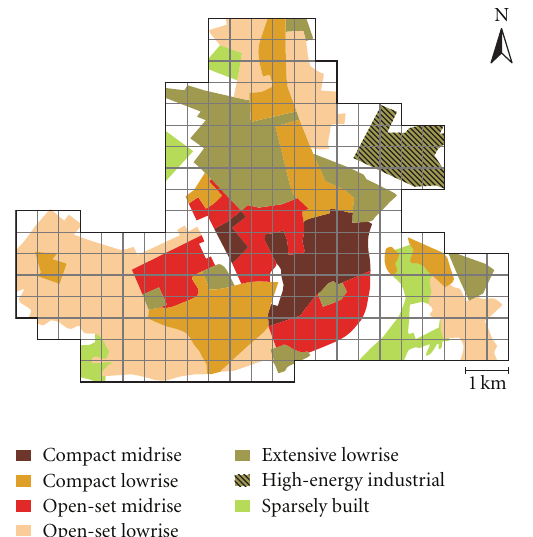
Figure 6: Spatial distribution of urban Local Climate Zones (based on [7]) occurring in the study area of Novi Sad.